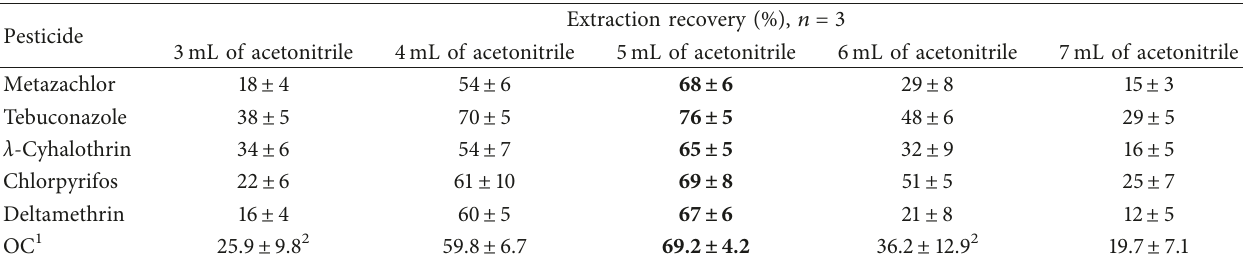
Table 3: Effect of the desorbing solvent volume on extraction efficacy of the five pesticides from rape oil samples.